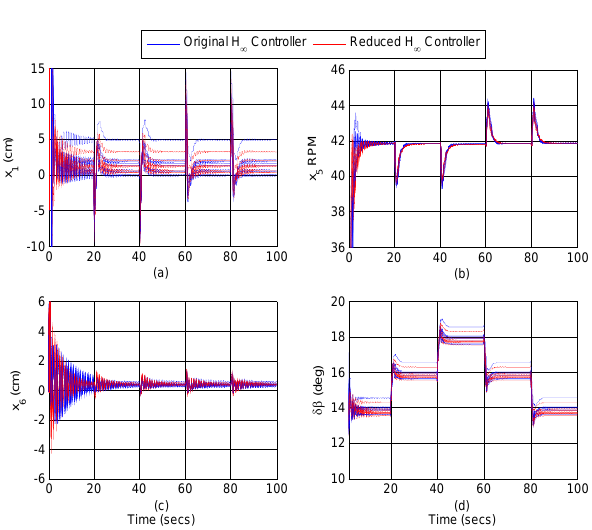
Figure 15. Transient responses of state variables (a- c) of wind turbine uncertain models (10 samples) with response to blade pitch angle (d) step changed inputs (14 0 , 16 0 , 18 0 , 16 0 , 14 0